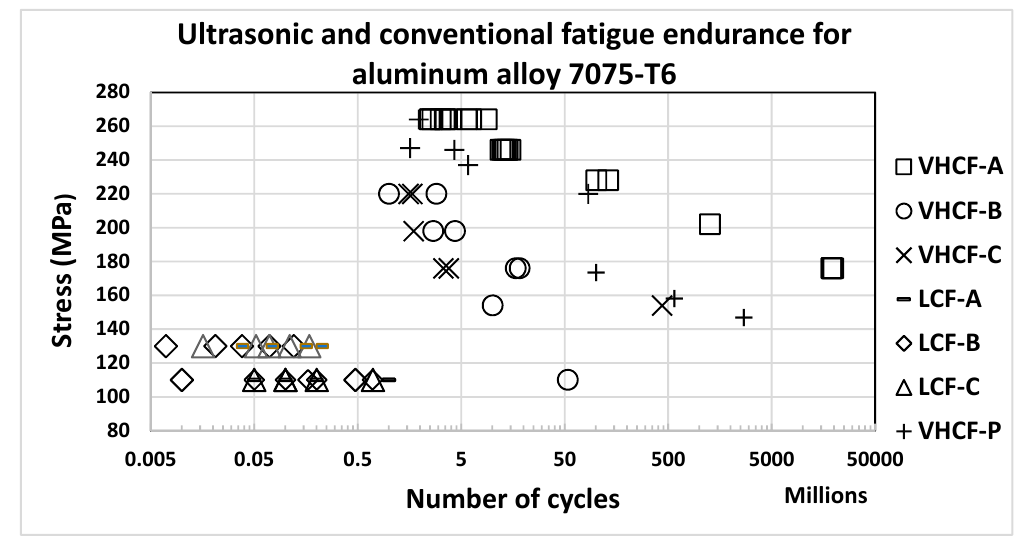
Figure 9. Results of ultrasonic and conventional fatigue tests.